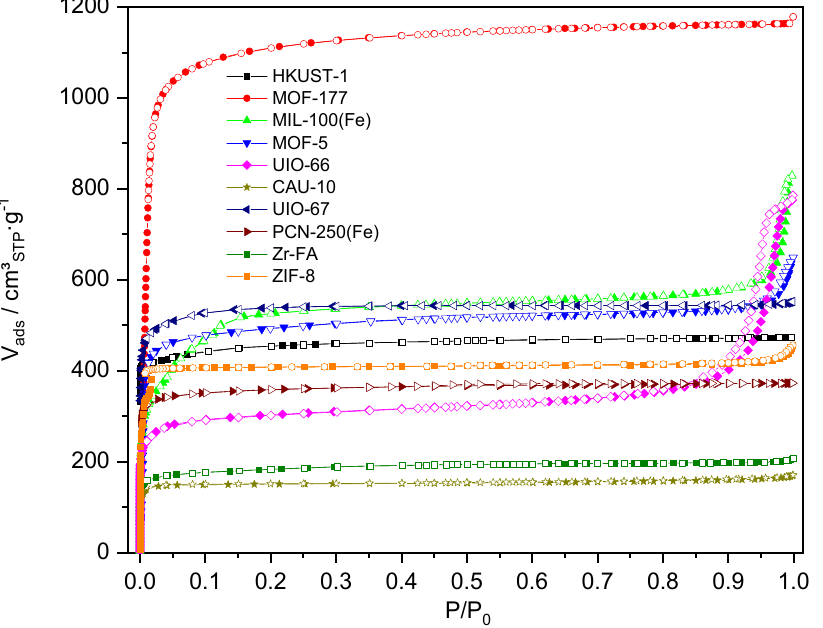
Figure 3. N 2 adsorption/desorption isotherms at 77 K for MOFs. Open symbols are used for the desorption branch.